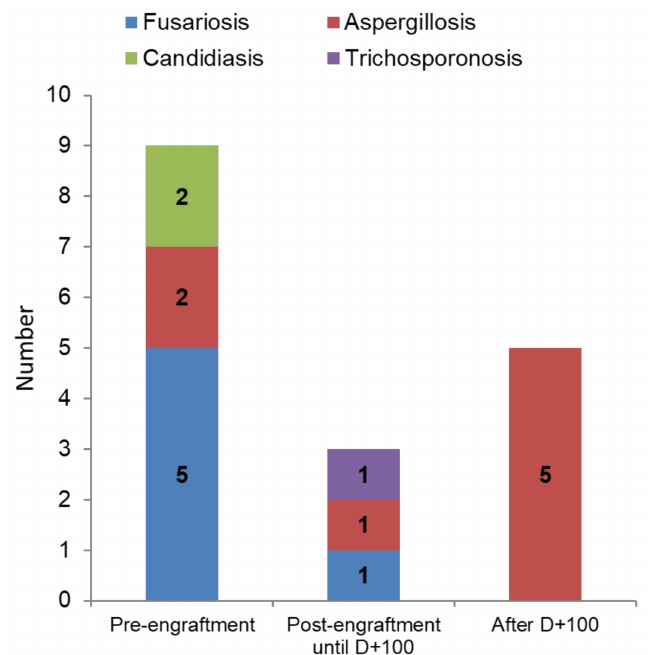
Figure 1. Distribution of invasive fungal disease in allogeneic hematopoietic cell transplant recipients according to the period